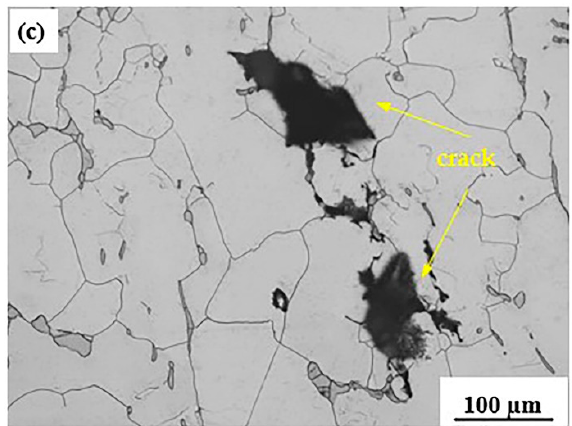
Figure 9. Metallographic diagram of fracture zone at 200 times magnification: ( a ) 1000 °C, ( b ) 1100 °C, ( c ) 1200 °C.